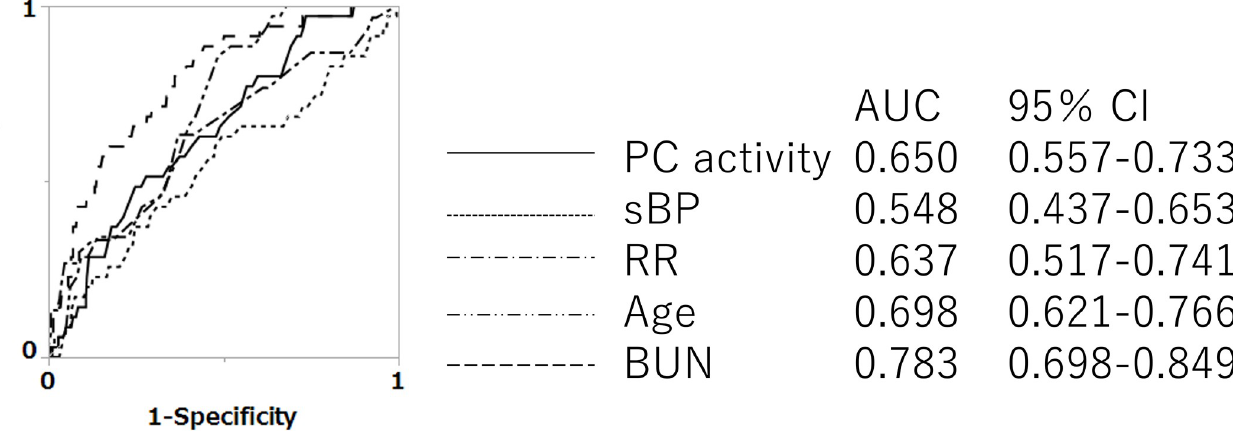
Fig 4. ROC curves of PC activity and each continuous variable of CURB-65 for predicting in-hospital death of all-pneumonia. PC = protein C; sBP = systolic blood pressure; RR = respiratory rate; BUN = blood urea nitrogen. � p < 0.05, † p < 0.01, comparing AUCs. The ROC curves of PC activity or each item of CURB-65 in all-pneumonia are shown. In all-pneumonia, the AUC of PC activity was the third highest; BUN had the highest AUC. There were significant differences between BUN and systolic blood pressure, respiratory rate, and PC activity (p < 0.01, < 0.05, and < 0.05,